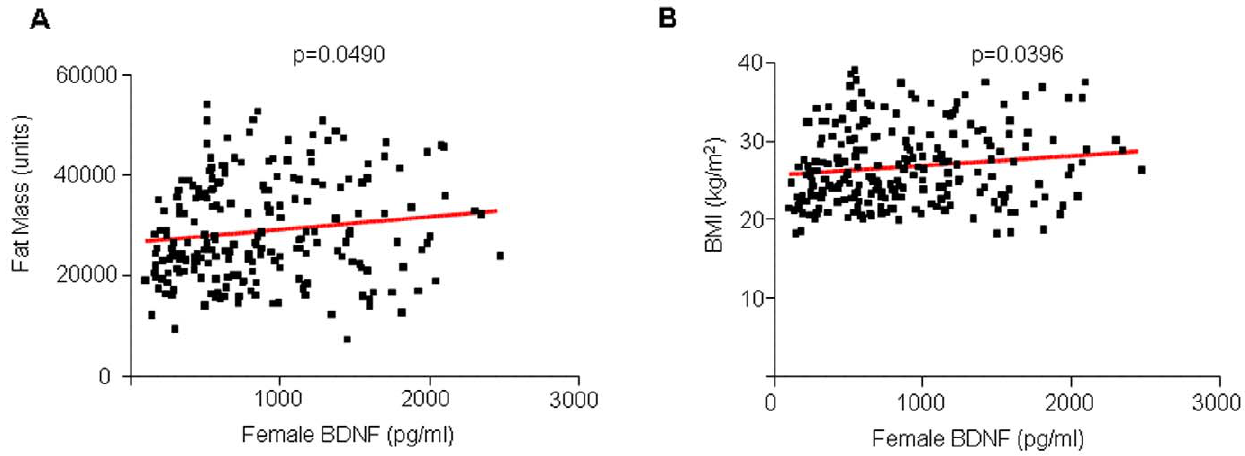
Figure 3. Linear regression analysis of plasma BDNF, fat mass and BMI in females. A and B. Plasma BDNF was positively correlated with fat mass (p=0.0490, R 2 =0.01825) and BMI (p=0.0396, R 2 =0.01843).